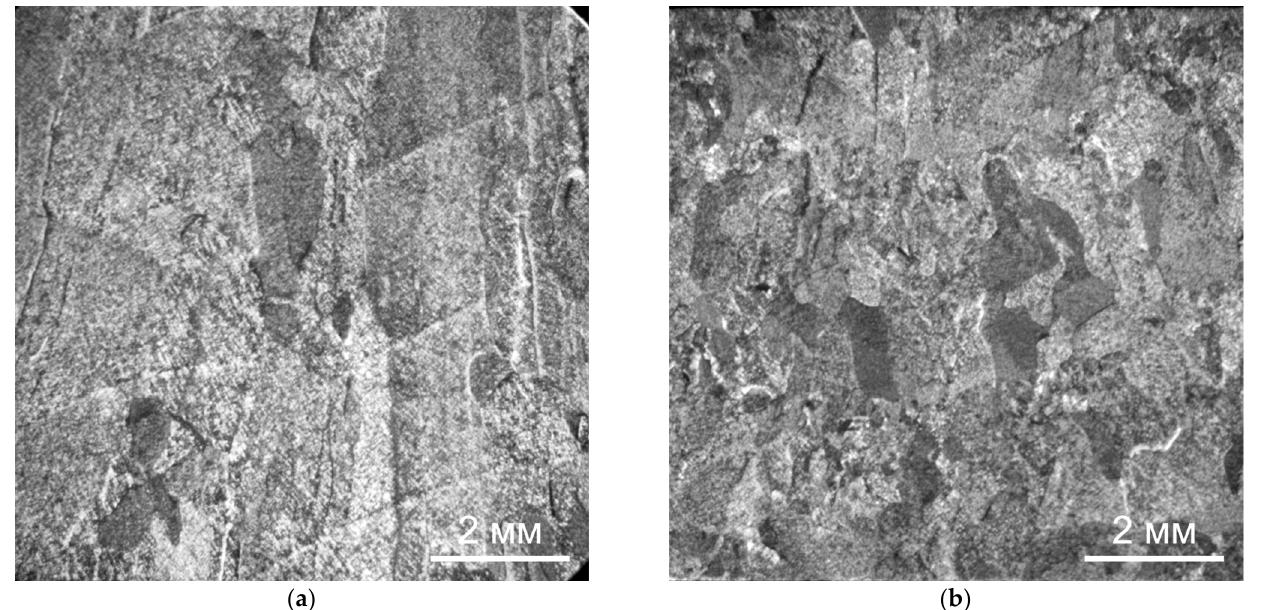
Figure 5. Macrostructure of the Ti-6Al-4V alloy during CMT deposition: ( a ) without forging, ( b ) with interpass forging.